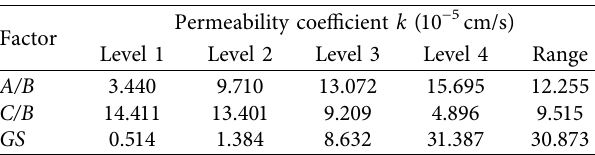
Figure 5: Sensitivity analysis of the softening coefficient. Table 8: Extremum difference analysis of the permeability coefficient.